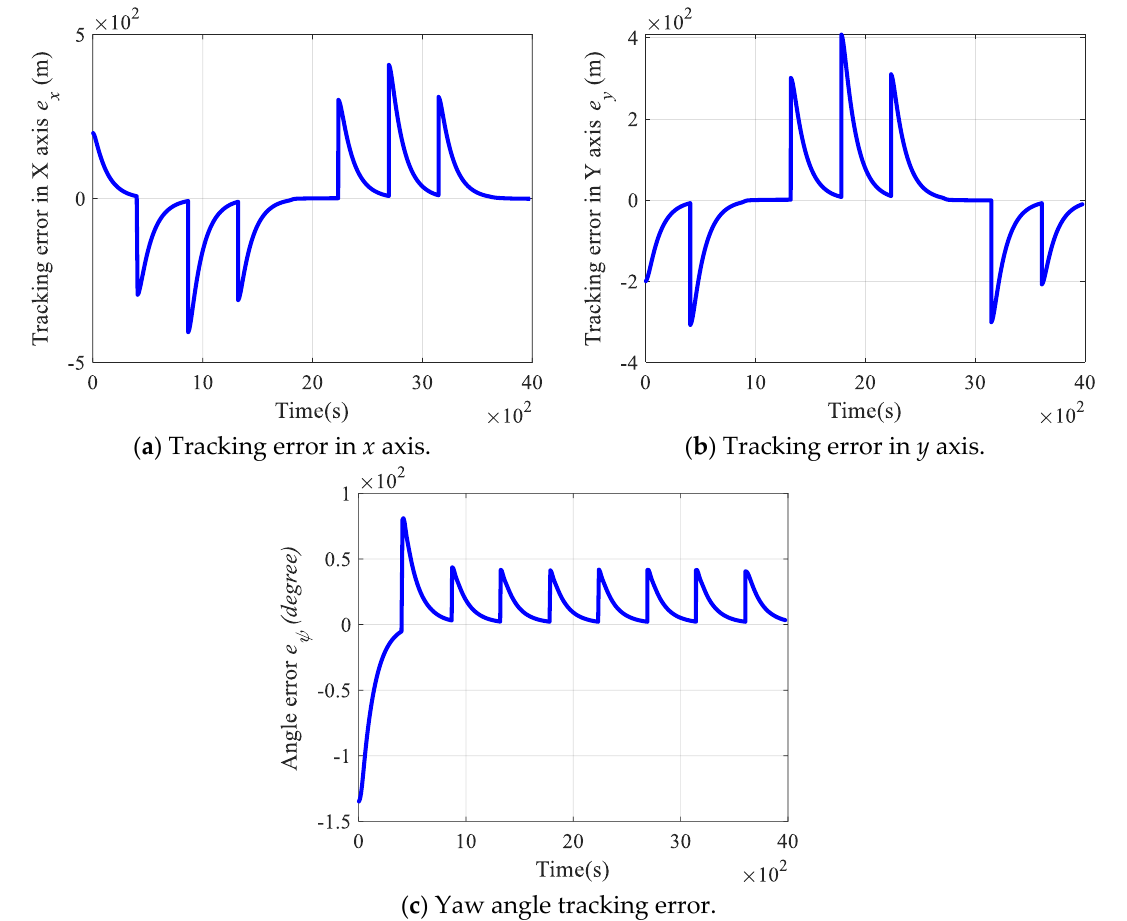
Figure 8. Tracking errors between controlled AUSV and waypoints.